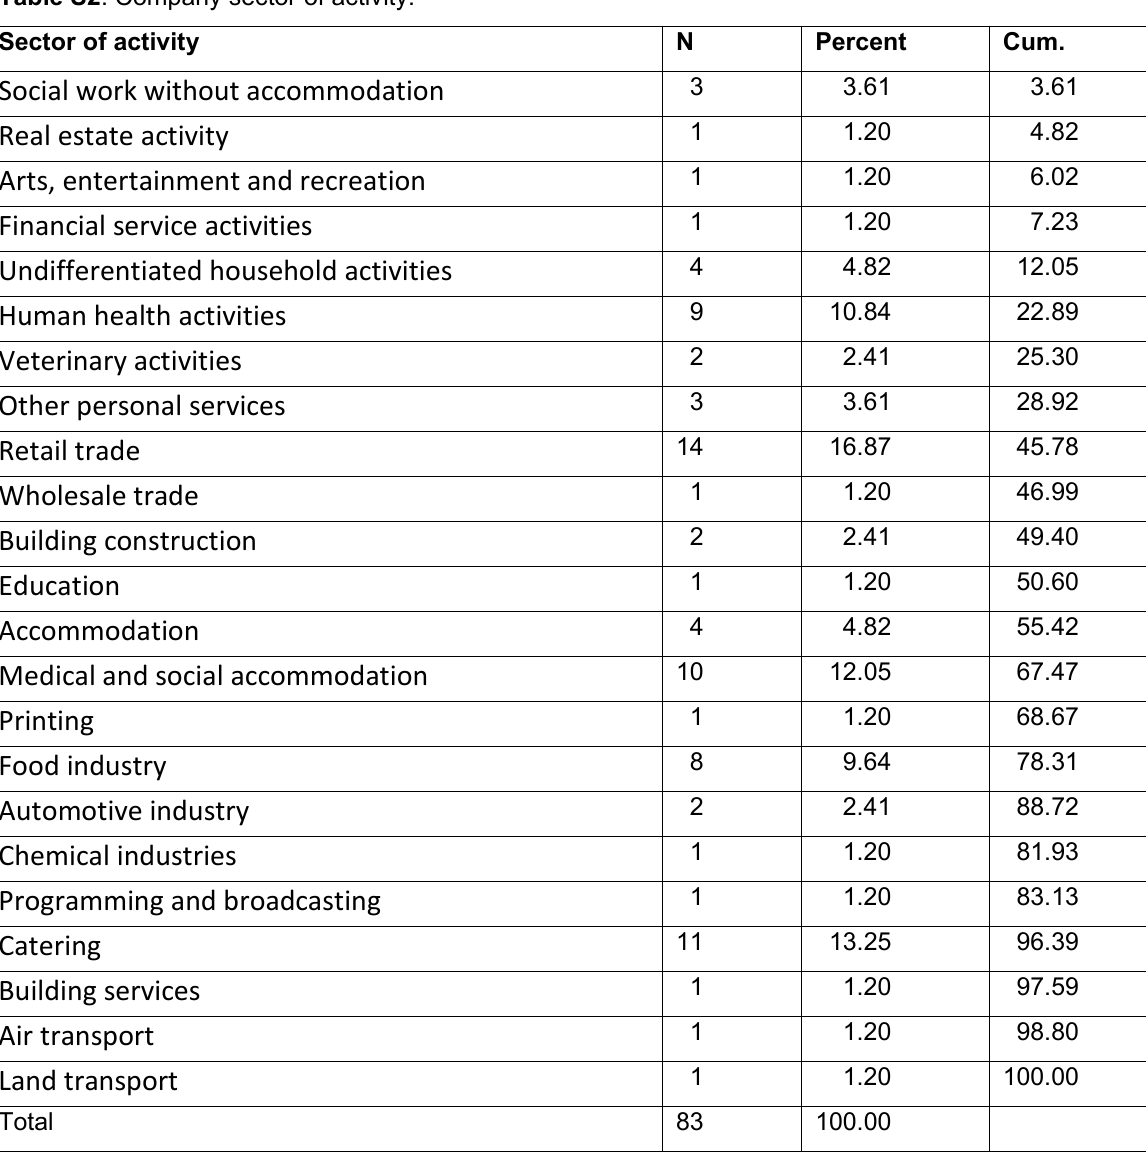
Table S2 : Company sector of activity. Sector of